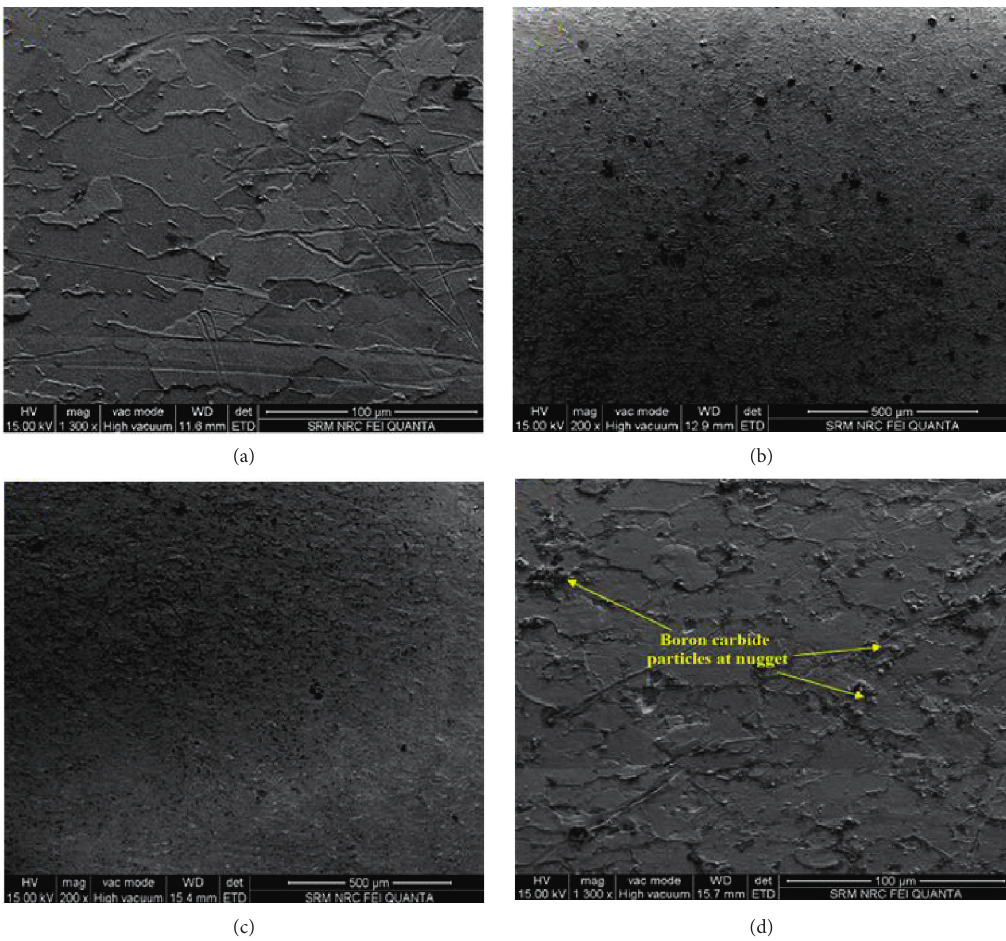
Figure 7: (a) SEM image of base copper. (b–d) SEM images of 3wt% B